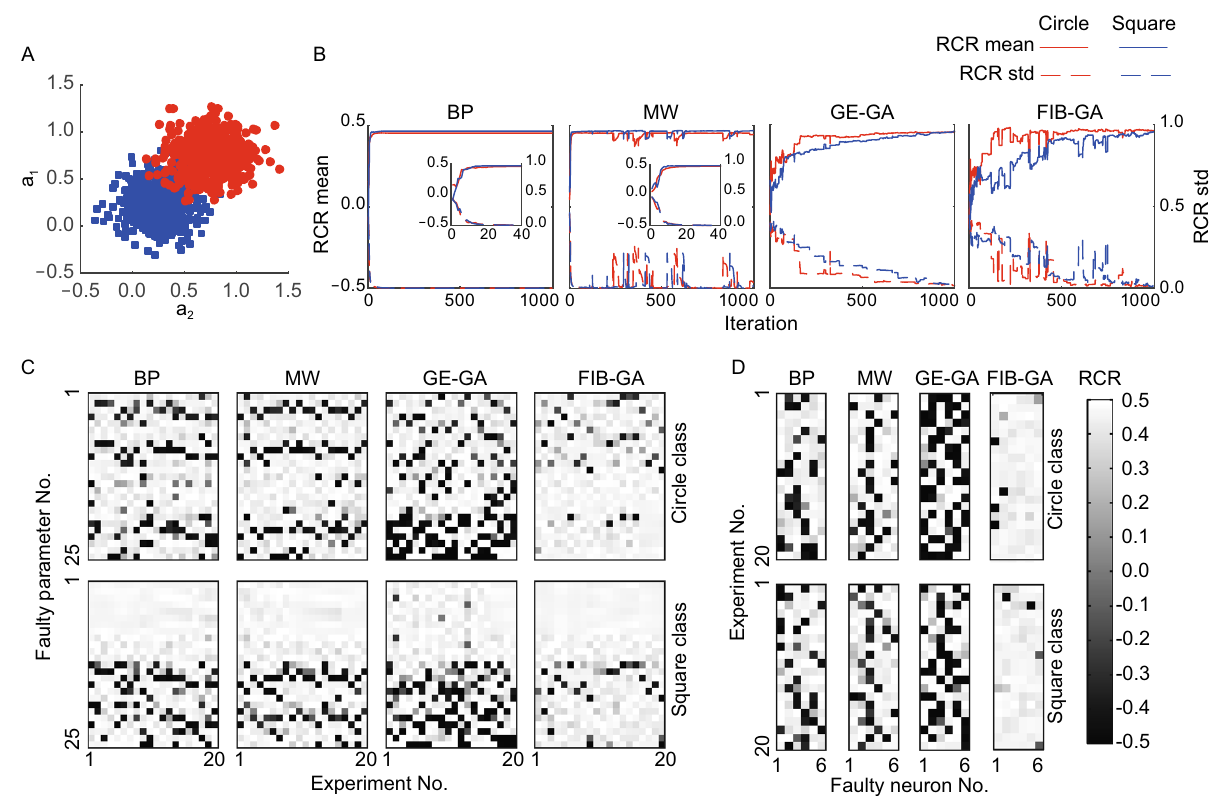
Figure 4. The FT performance of different ANNs with six hidden-layer neurons in solving an overlapping classi fi cation problem. (A) Two classes of Gaussian noise sources. (B) The plot of the relative correct rate versus the number of iterations. The inset shows the changes of the error within the initial 40 iterations. (C and D) The plot of errors versus the faulty parameters (C) and the plot of errors versus the faulty neurons in the hidden layer (D) in 20 independent experiments when using ANNs trained via BP, MW, GE-GA, and FIB-GA